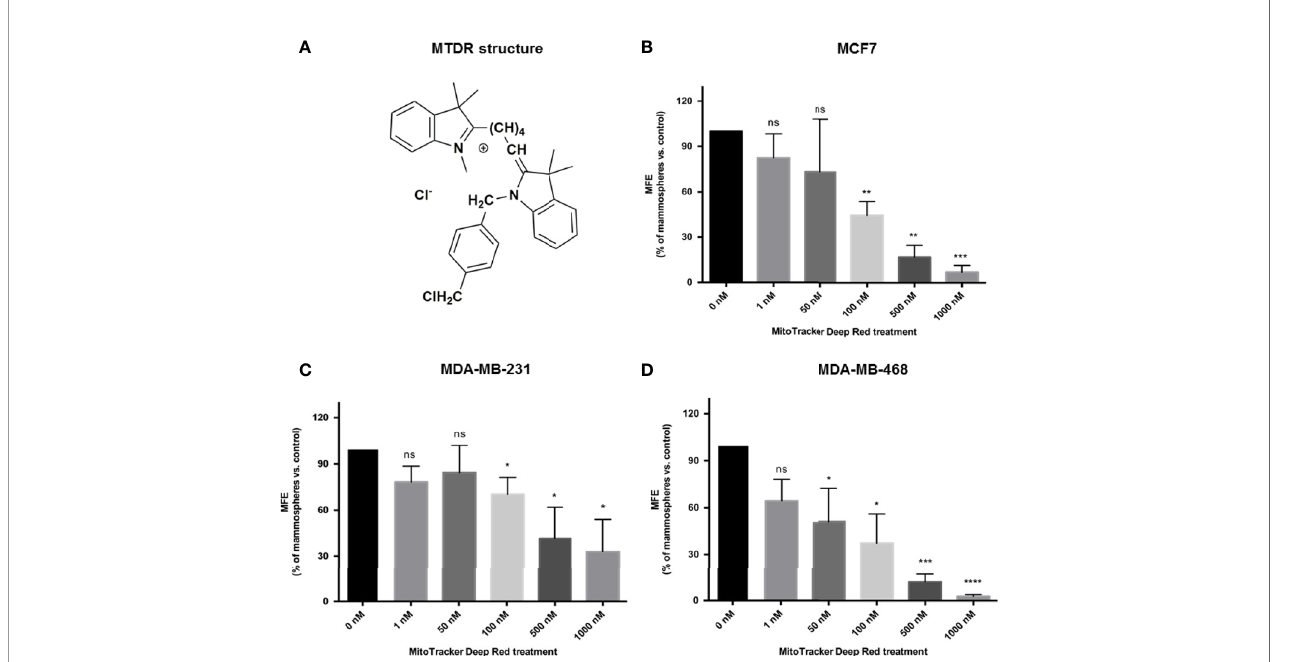
FIGURE 1 | MTDR inhibits mammosphere formation in MCF7, MDA-MB-231 and MDA-MB-468 cells. (A) Structure of MitoTracker Deep Red FM (MTDR). MTDR is a far-red fl uorescent dye that stains active mitochondria. Note that MTDR is a lipophilic cation, which is a chemical characteristic that results its high-ef fi ciency targeting to mitochondria. (B) Effects of MTDR on 3D mammosphere formation in MCF7 cells. Note that MTDR inhibits 3D anchorage-independent growth in MCF7 cells, with an IC-50 of <100 nM. (C) Effects of MTDR on 3D mammosphere formation in MDA-MB-231 cells. Note that MTDR inhibits 3D anchorage-independent growth in MDA-MB-231 cells, with an IC-50 between 100 and 500 nM. (D) Effects of MTDR on 3D mammosphere formation in MDA-MB-468 cells. Note that MTDR inhibits 3D anchorage-independent growth in MDA-MB-468 cells, with an IC-50 between 50 and 100 nM. The statistical test used was a one-tail unpaired